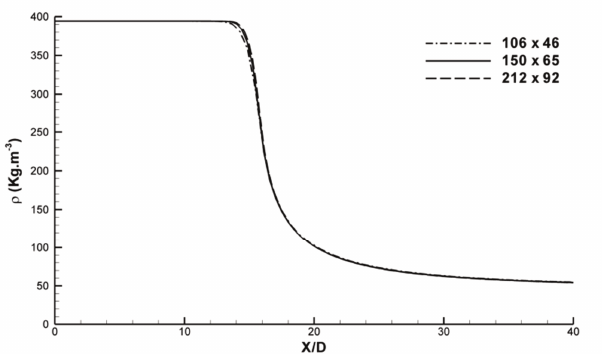
Fig. 3. Grid size dependency test based on the axial density distribution In order to evaluate the influence of the grid on the con- verged solution grid dependency tests had to be